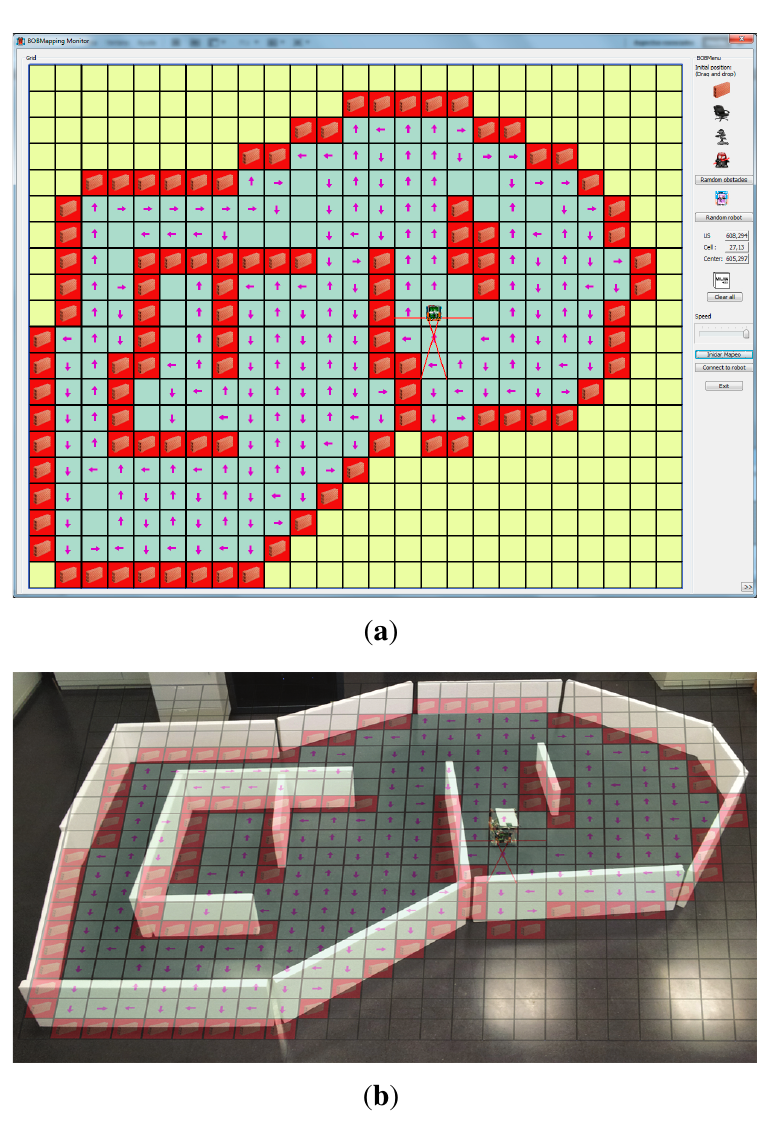
Figure 5. Backtracking Occupancy Grid-based Mapping (BOBMapping) experiment. ( a ) The monitoring application result after the mapping process (green = empty; red = occupied, yellow = not sensed). The arrows trace the route of the robot. ( b ) The resulting grid has been superimposed on to the environment